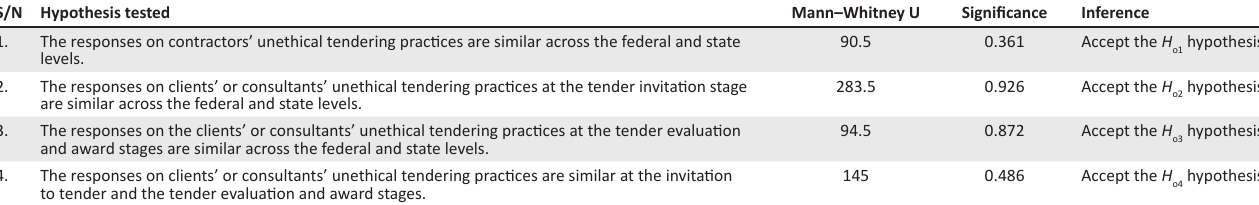
TABLE 7: Mann–Whitney U test of differences in the opinions of respondents. S/N Hypothesis